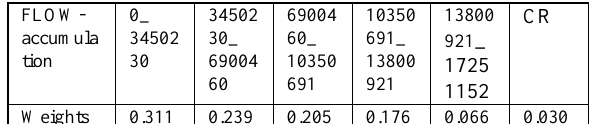
Table 8. Weights of group FAHP for subclasses of FLOW ACC